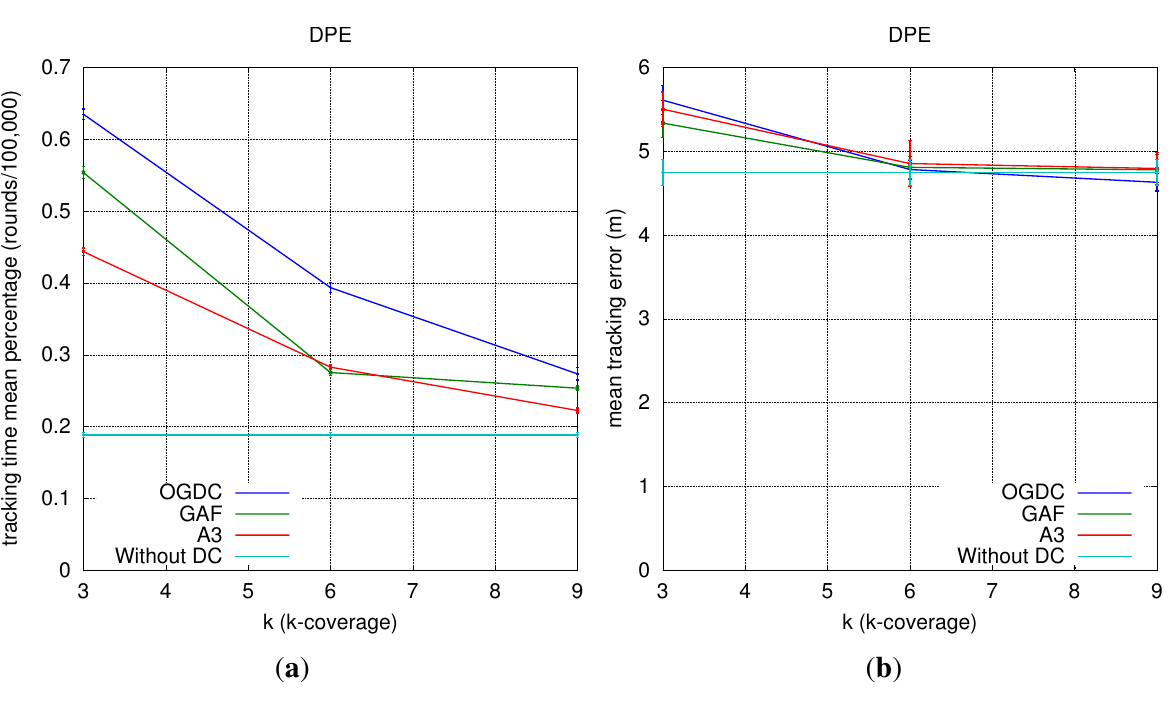
Figure 14. Impact of k on Target Tracking. ( a ) Mean Tracking Time (DPE); ( b ) Mean Tracking Error